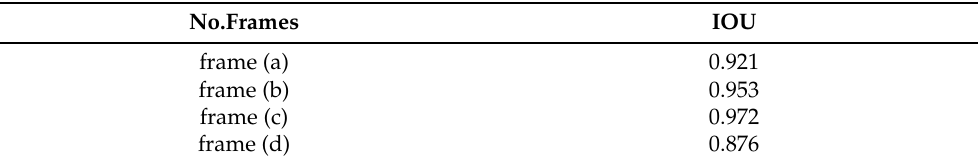
Table 3. The IoU metric measures the overlap percentage between the ground truth and prediction.